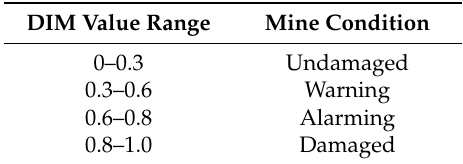
Figure 2. Complete framework of blockchain-IoT network for the use case of an underground coal mine-SHM. Table 1. Categories of the structural states of an underground coal mine with respect to the damage index of mine (DIM) values.